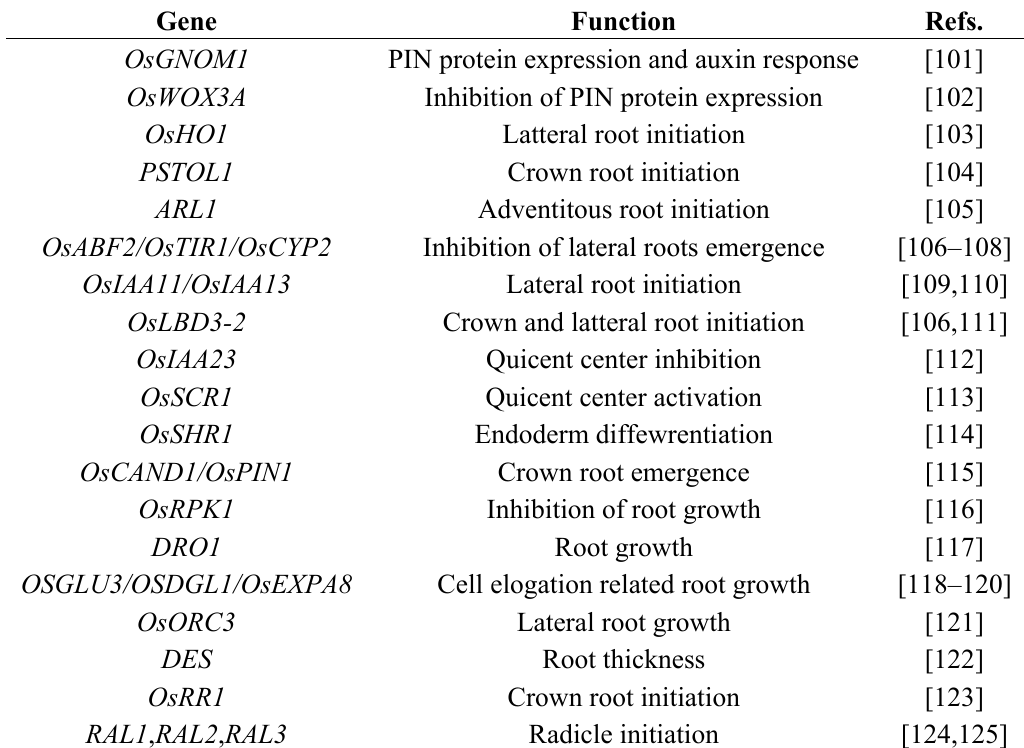
Table 3. Rice root growth and development related